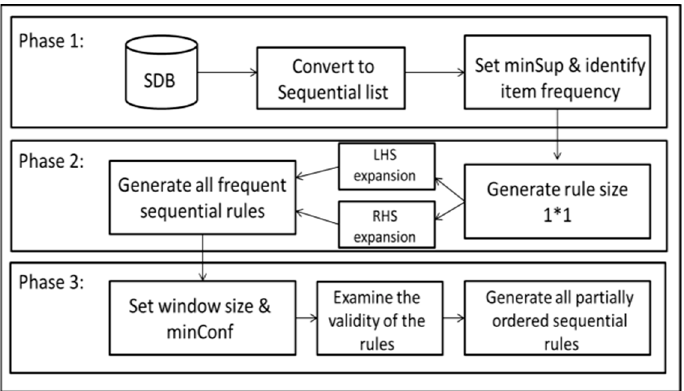
Figure 1. The RuleGrowth algorithm framework based on [31].